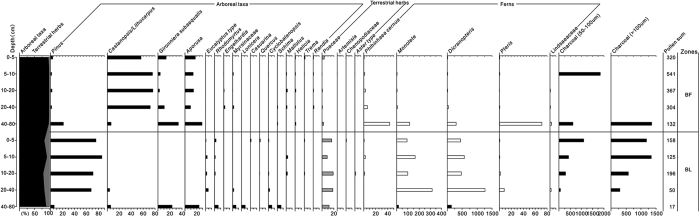
Pollen profile at broadleaved forest and bare land in Guangdong, South China.Note: BF = broadleaved forest (regional climax); BL = bare land. The Y axis on the left indicates soil depth (cm).